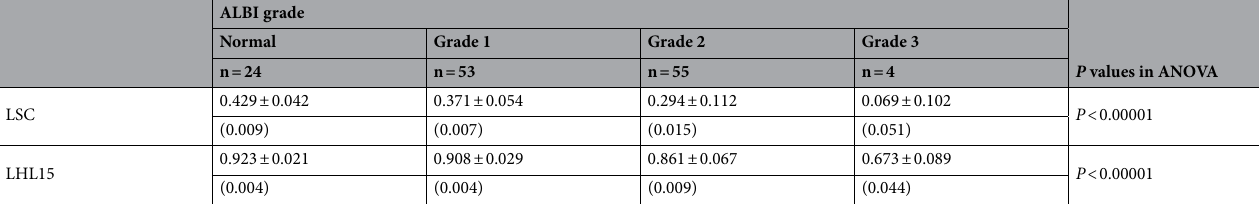
Table 3. Comparative table of the albumin-bilirubin (ALBI) Grade with the liver–spleen contrast (LSC) and receptor index (LHL15). The ‘ Normal’ is a group of patients who are at Grade 1 but have neither chronic liver